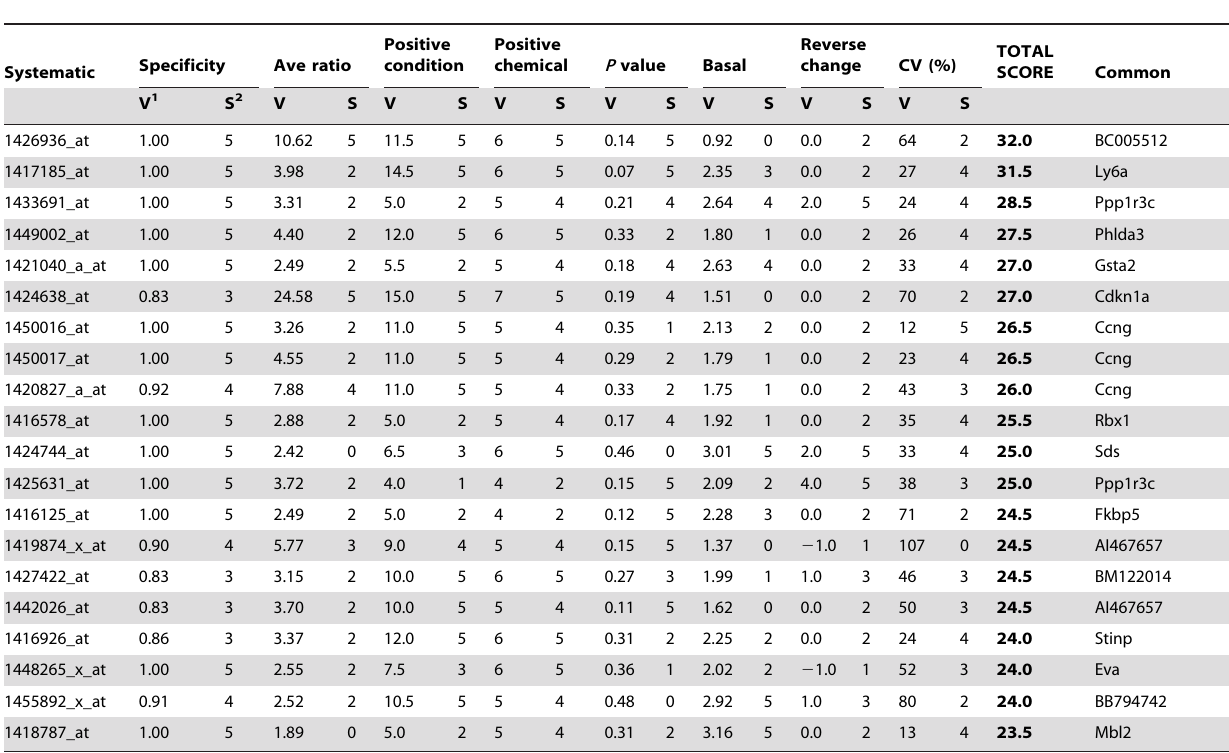
1 ‘‘V’’ represents values. 2 ‘‘S’’ represents score. Only the top 20 genes are shown. A full list is attached in Table S3. Detailed scoring rules are described in the supporting information. ‘‘Pink cells’’ represent up-regulation and ‘‘blue cells’’ represent down-regulation. Specificity =(number of total pink cells in GTXs)/(number of total pink cells in GTXs and NGTXs); Ave ratio =average of ratios of all pink cells in GTXs; Positive condition =number of total pink cells in GTXs. Since DEN was duplicated, each pink cell was considered 0.5; Positive chemical =number of GTXs with at least one pink cell; P value was calculated by t test of signal intensity between GTXs and NGTXs in GeneSpring software; Basal represents basal expression level, equals to log 10 value of signal intensity of control animals; Reverse change reflects opposite change of gene expression in different treatment groups. Reverse change=number of blue cells in NGTXs - number of blue cells in GTXs; CV% =100 6 SD/MEAN% based on the signal intensity of all control animals. Total score =Score of 2 6 Specificity + Ave ratio + Positive condition + Positive chemical + P value + 0.5 6 Basal + 0.5 6 Reverse change + 0.5 6 CV%.